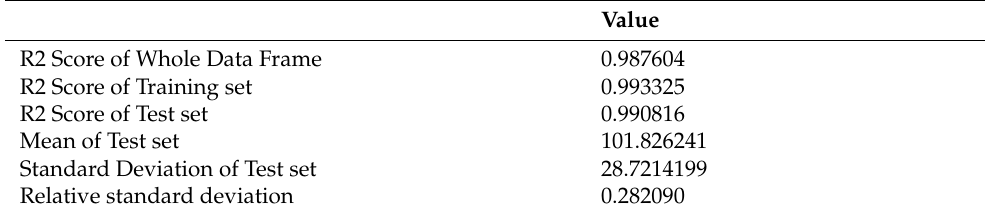
Table 3. Model evaluation results.